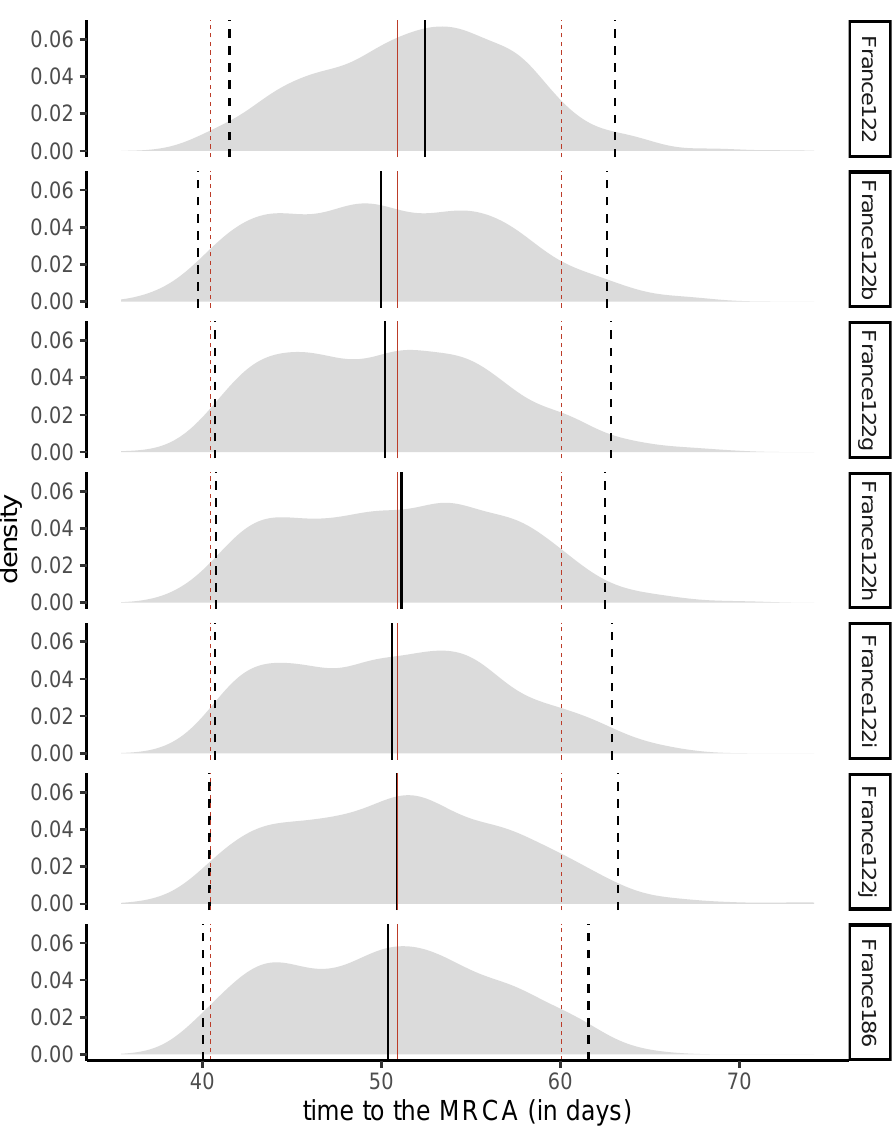
Figure S4 – Time to the MRCA for the France186 dataset and subsets with 122 sampled sequences assuming the BDSKY model. The red lines show the quantiles (0.025, 0.5, and 0.975) for the average of the 10 datasets. The black line shows the quantile for each dataset, and we can see how it behaves compared to the average. The last panel shows the largest phylogeny built without sampling, i.e. using all 186